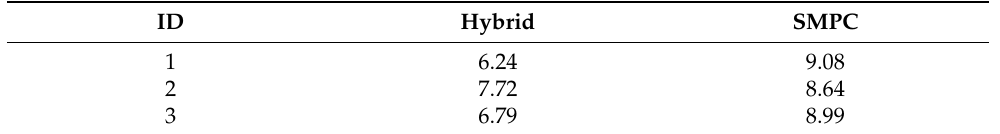
Table 11. Runtime (s) of calculating the p -value of the t statistic and degree of freedom previously calculated in Table